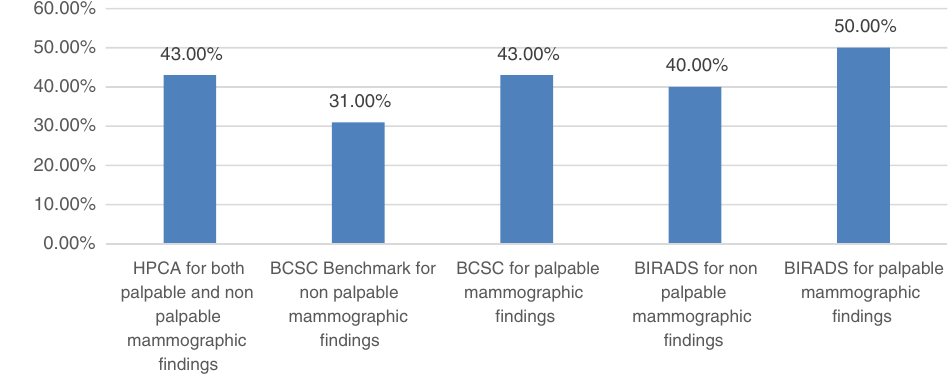
Fig. 2 PPV2 showing how frequently the performed biopsies indicate